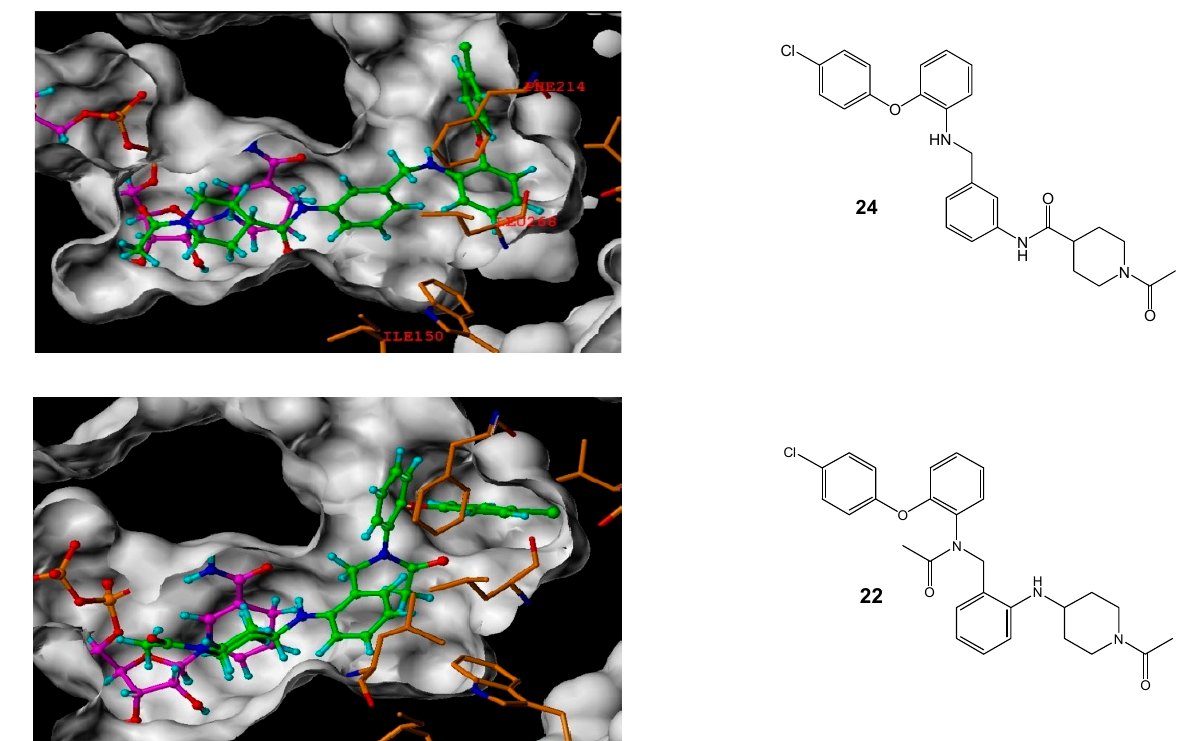
Figure 7. Compounds 24 and 22 docked into the 17 β -HSD3 homology model.